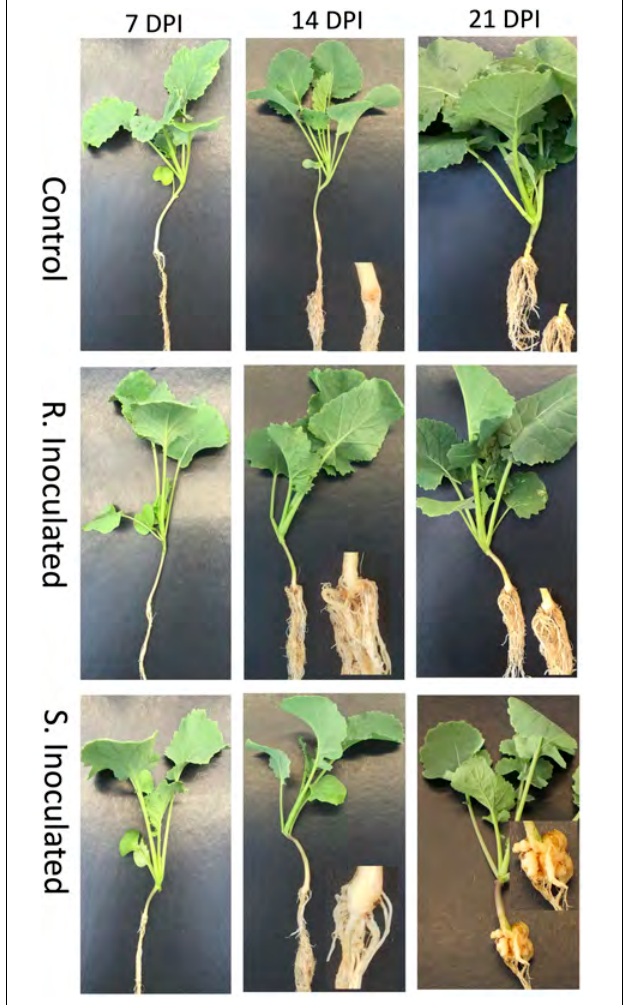
FIGURE 1 | Clubroot gall development following inoculation with P. brassicae pathotype 3. Control at 7-, 14-, and 21-DPI, Clubroot resistant (CR) inoculated line at 7-, 14-, and 21-DPI Clubroot susceptible (CS) inoculated 7-, 14-, and 21-DPI.